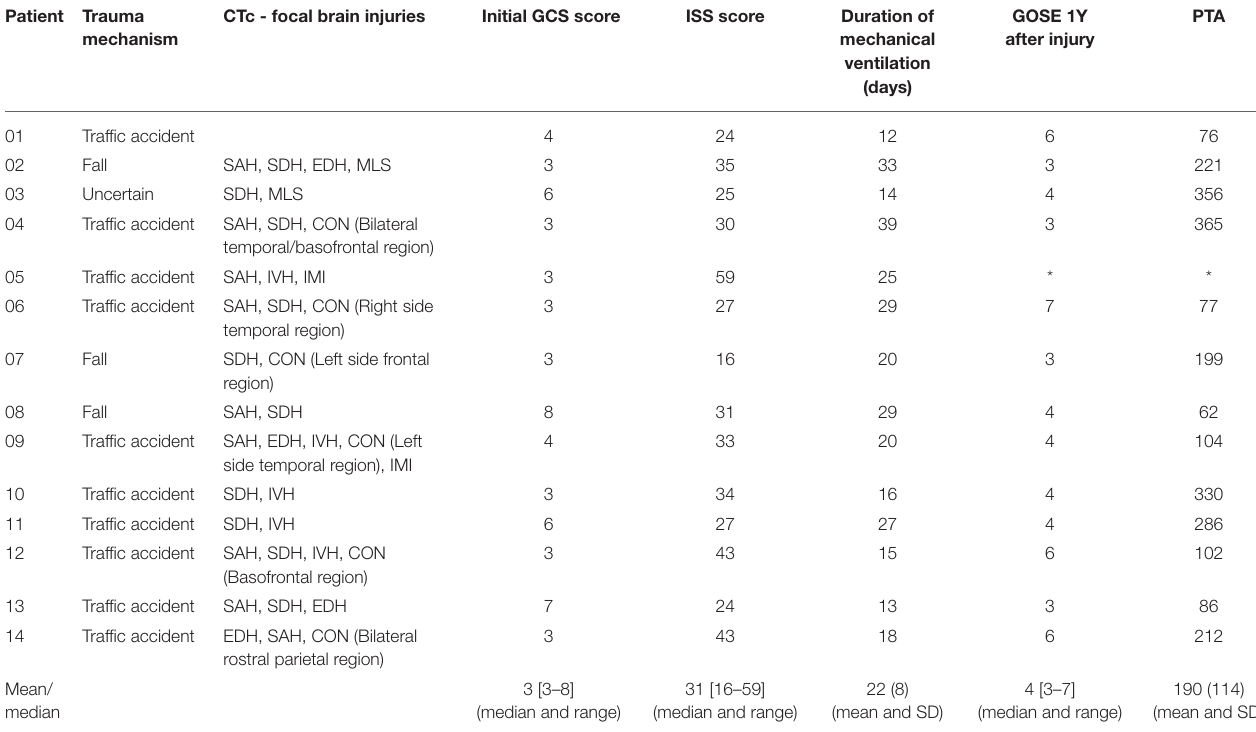
TABLE 1 | Patients’